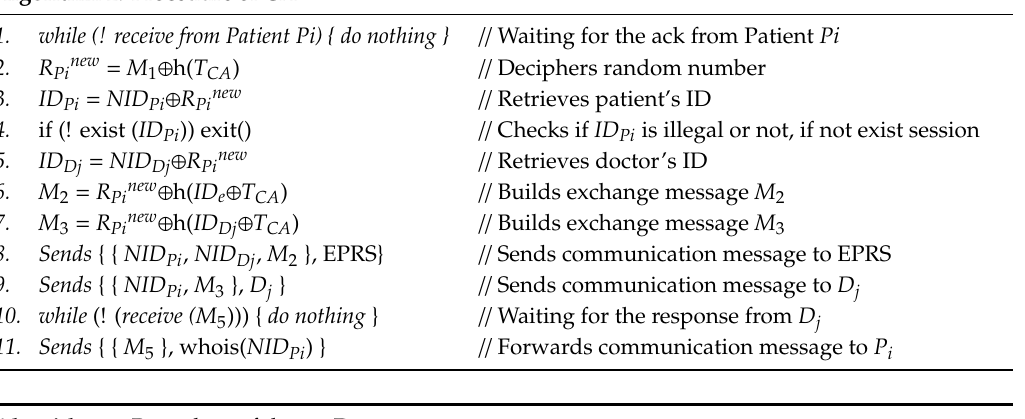
Algorithm 2: Procedure of CA